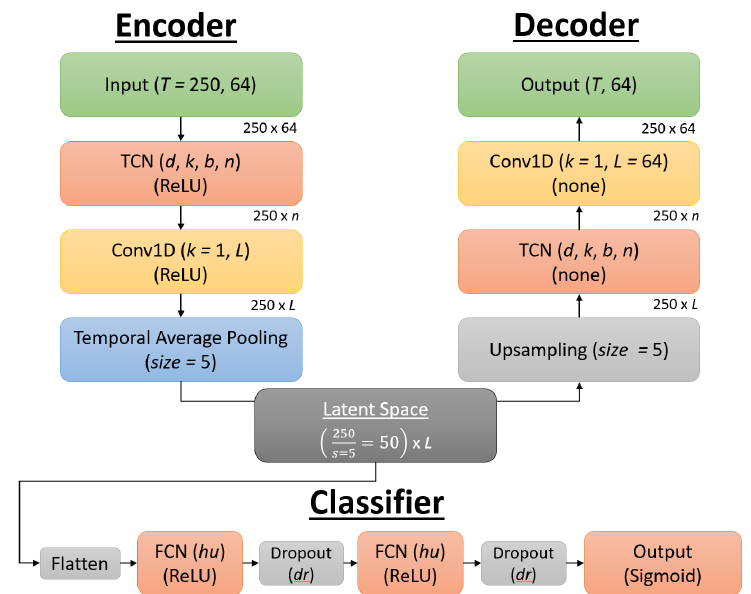
Figure 10. Visual representation of the TCN-AE classifier. The Encoder and Decoder comprise the AE architecture, with the latent space then used as input to the FCN classifier shown at the bottom. The FCN classifier architecture consists of two fully-connected hidden layers with hidden units hu , each followed by a dropout layer with a dropout rate dr .